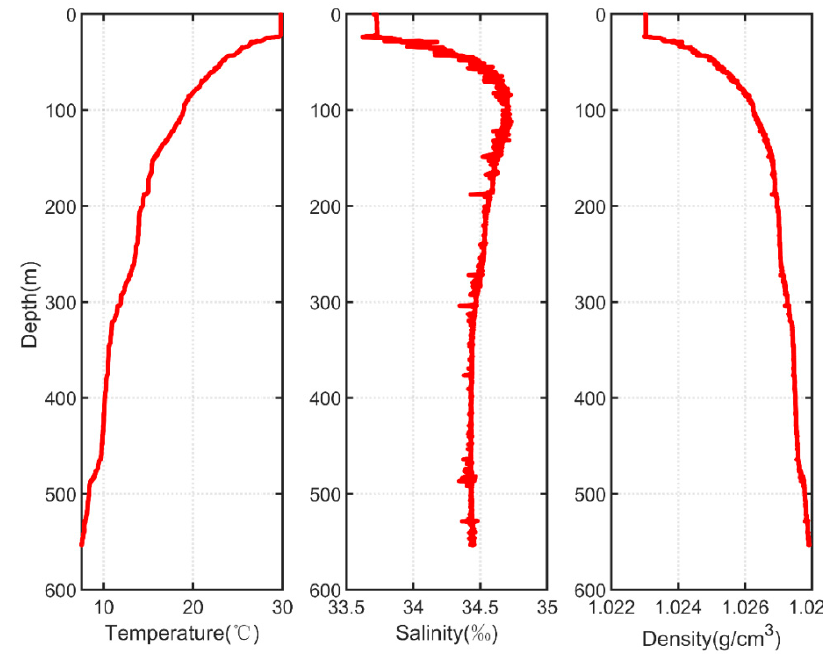
Figure 6. Depth profiles of temperature, salinity, and density in the South China Sea.